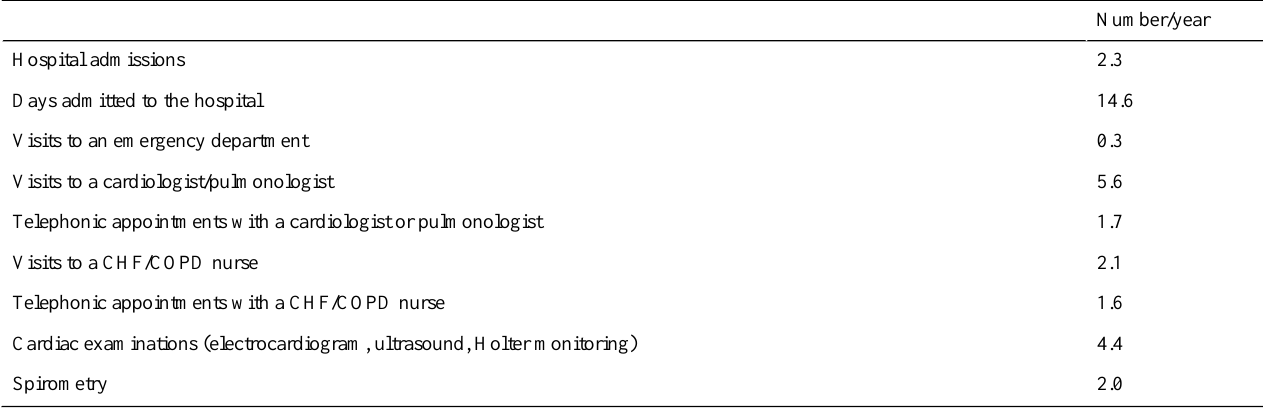
Table 1. Average annual health care consumption by patients with combined chronic heart failure (CHF) and chronic obstructive pulmonary disease (COPD)